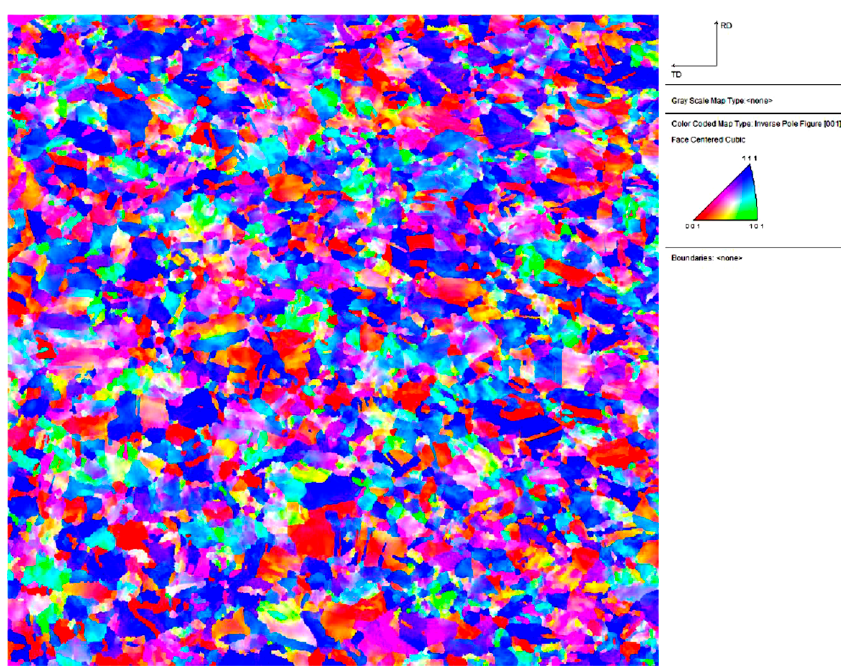
Figure 4. Electron backscatter diffraction (EBSD) grain map of the PHILOS plate.